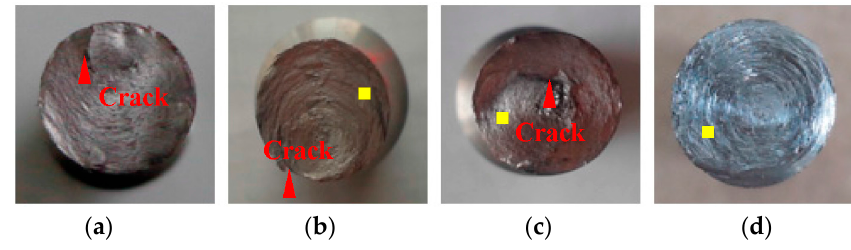
Figure 6. Failure modes under torsion. ( a ) Q235; ( b ) AL6061; ( c ) SS316; ( d ) LYS160.